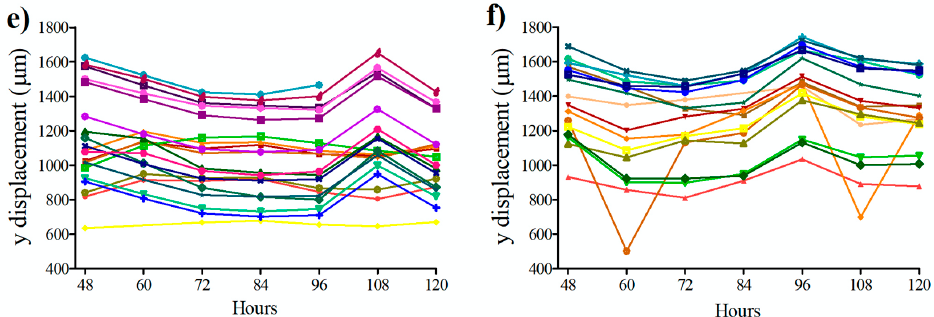
Figure 4. Migration of single cells in the microfluidic cell culture chamber. Coordinates of the cells in the microfluidic cell culture device were measured every 12 h between 48 to 120 h. Movement of the U87 cells ( a ) at x-y axes ( b ) on the x -axis, ( c ) on the y -axis. Movement of the U87-C cells ( d ) at x - y axes, ( e ) on the x -axis, ( f ) on the y -axis. The number of analyzed cells for each group is 20. U87 indicates that cells cultured in DMEM medium, U87-C defines that cells were grown in 50% DMEM and 50% macrophage-used RPMI medium. Each color represents the single cells and color coding was consistent in each group.